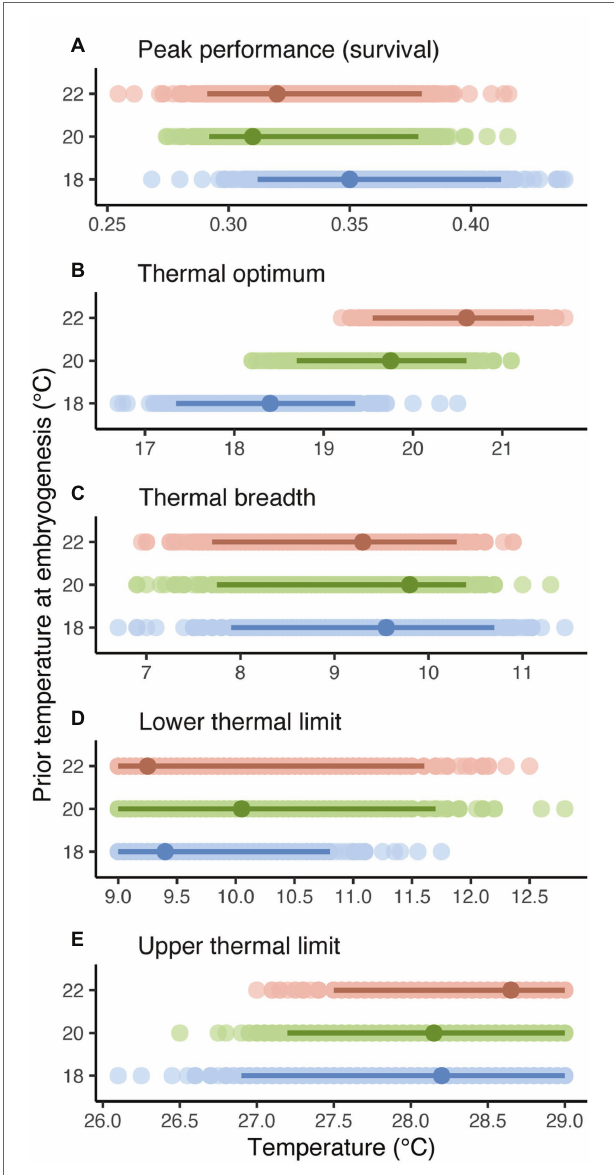
FIGURE 3 | Peak performance (A) , thermal optimum (B) , thermal breadth (C) , and thermal limits (D,E) for successful survival of planktonic development after embryogenesis at 18, 20, or 22°C (thermal performance was unaffected by fertilization at different temperatures before embryogenesis). Darker points and intervals are mean estimates and 95% CIs for curve descriptors, based on 1,000 bootstrap replicates (lighter points). See bootstrapping details in Materials and